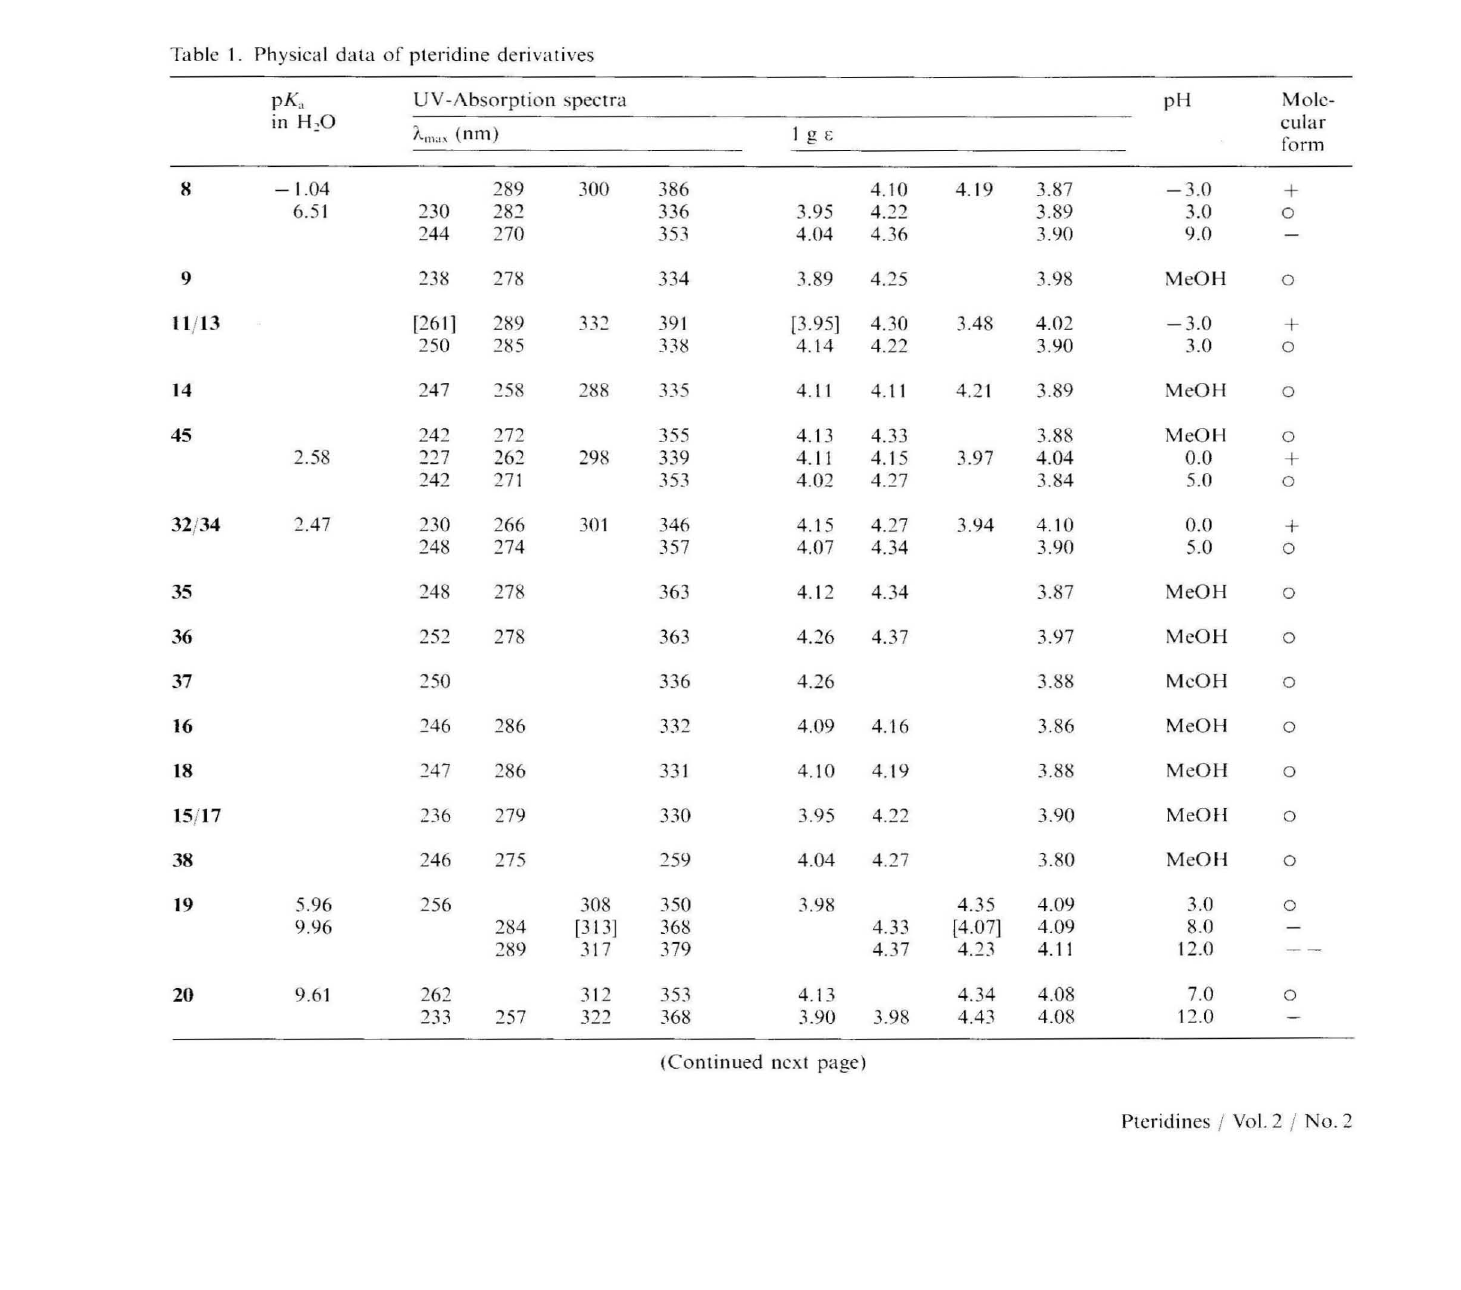
Table 1. Physical data of pteridine